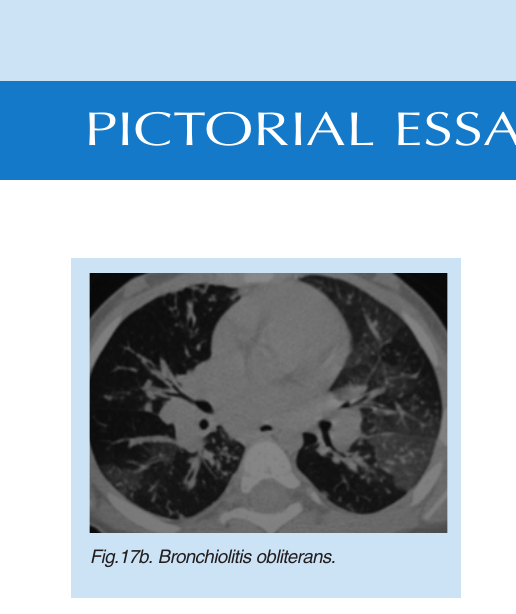
Fig. 20a. Noonan’s.